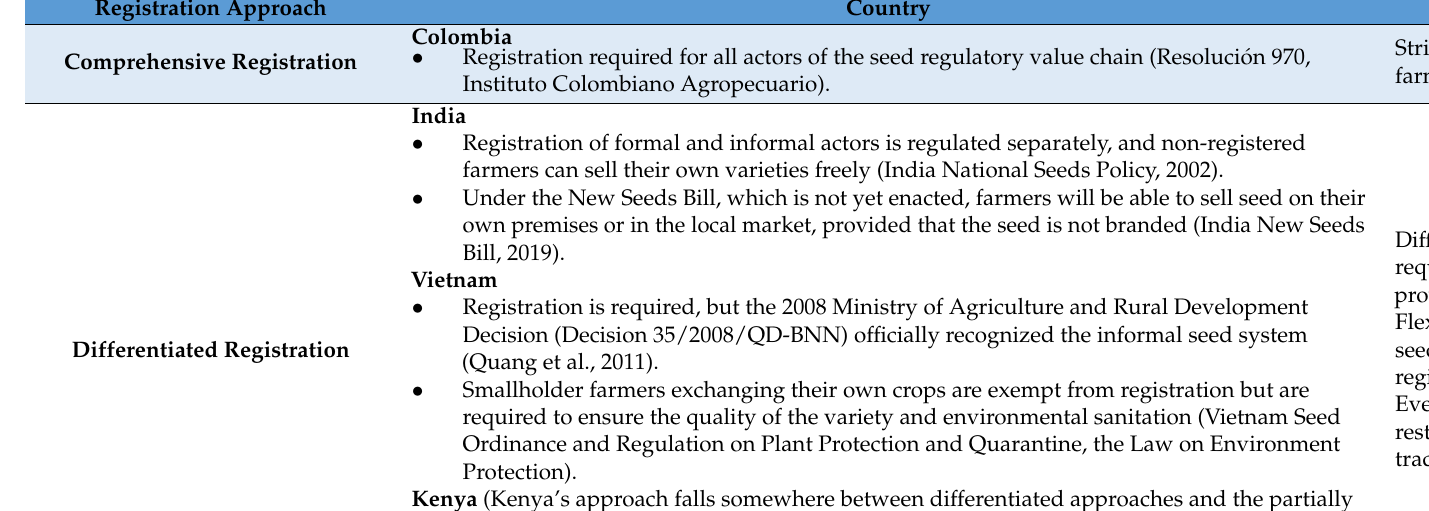
Table 1. Regulatory approaches to registration of seed actors and venues (illustrative